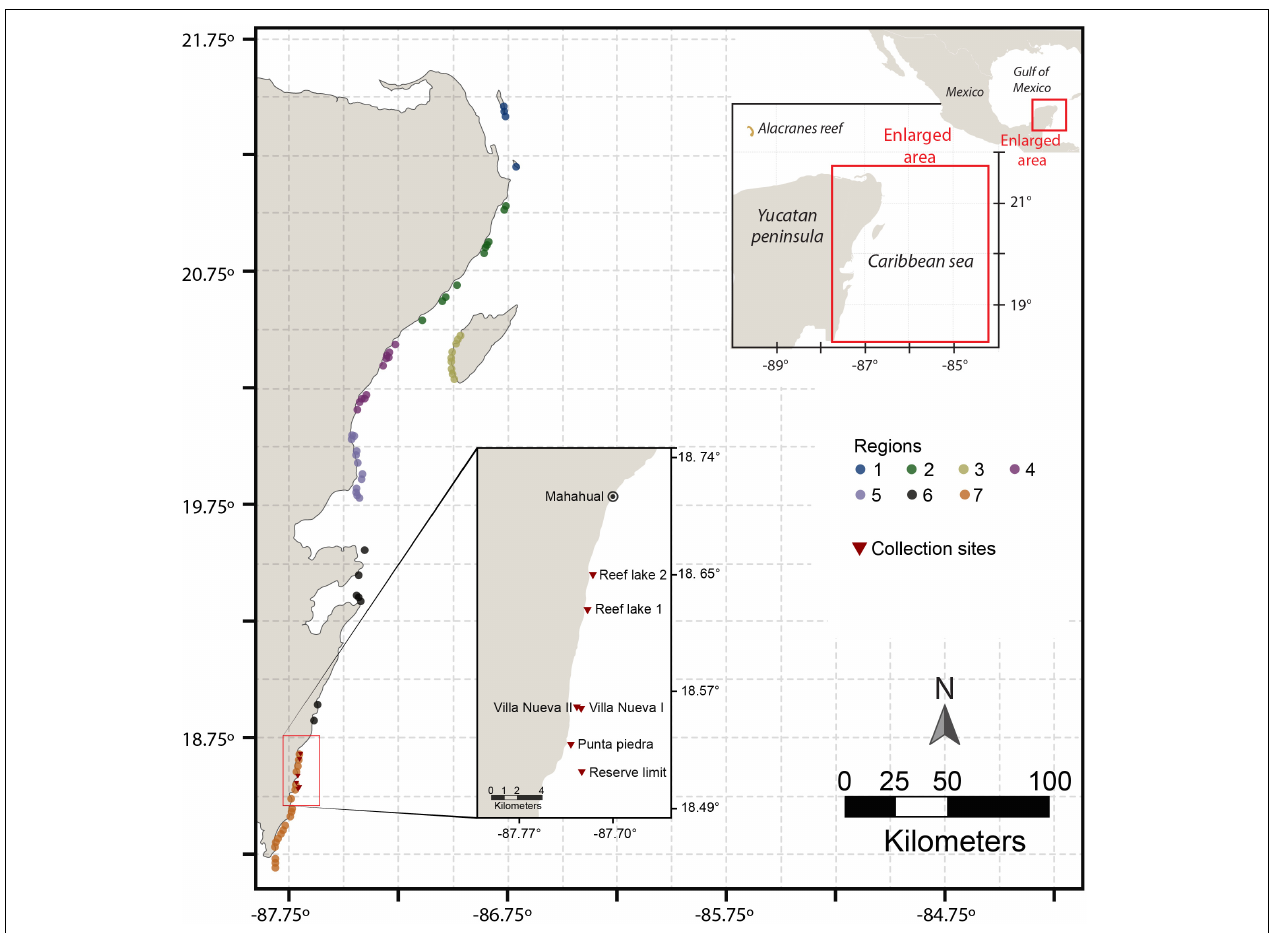
FIGURE 1 | Location of sites off the Mexican Caribbean coast of Quintana Roo, where immersions to cense populations of Bartholomea annulata and Condylactis gigantea and their crustacean symbionts took place. The study area was subdivided in seven regions (for details see Campos-Salgado, 2009). Sites where experimental animals were collected are also